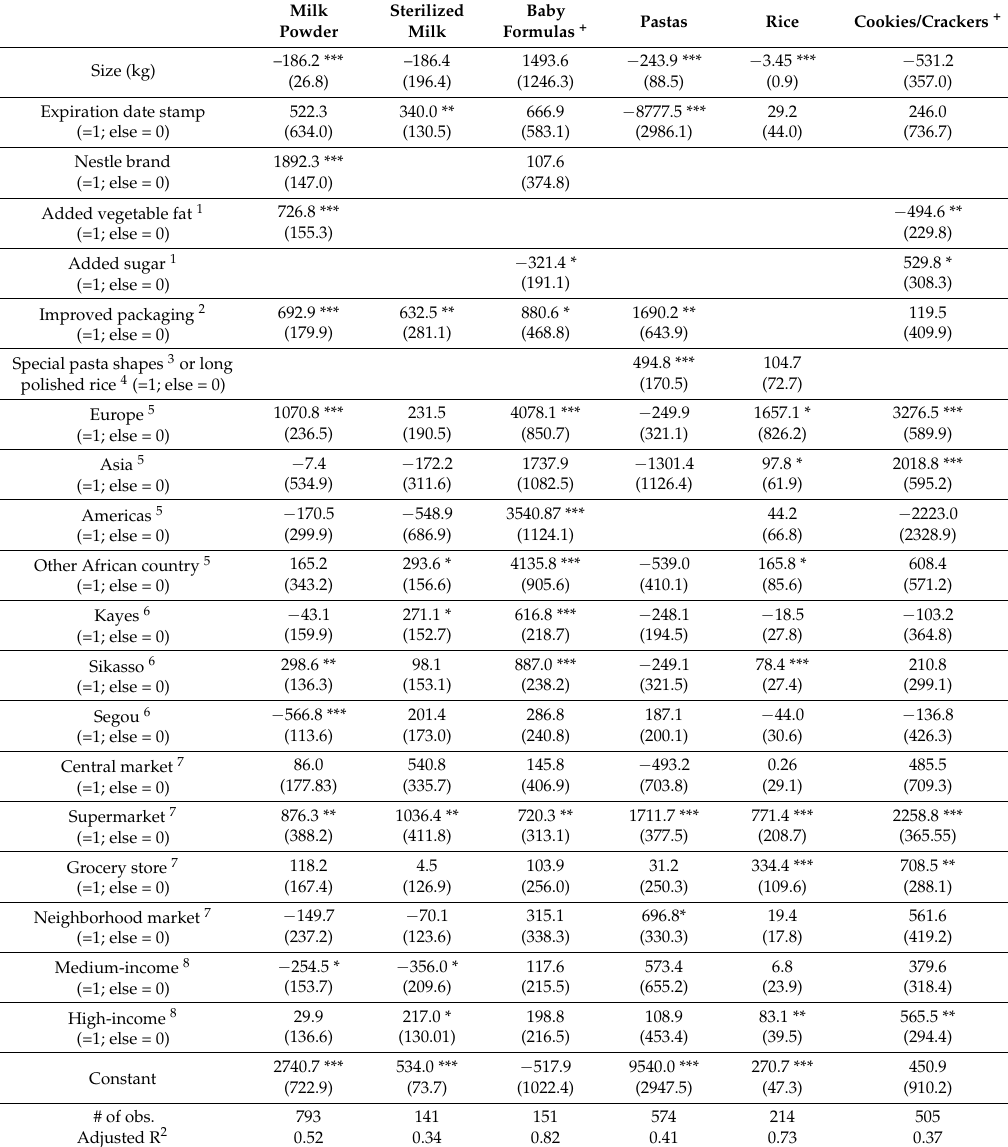
Table 4. Hedonic price regressions for processed dairy and grain products (FCFA/kg).